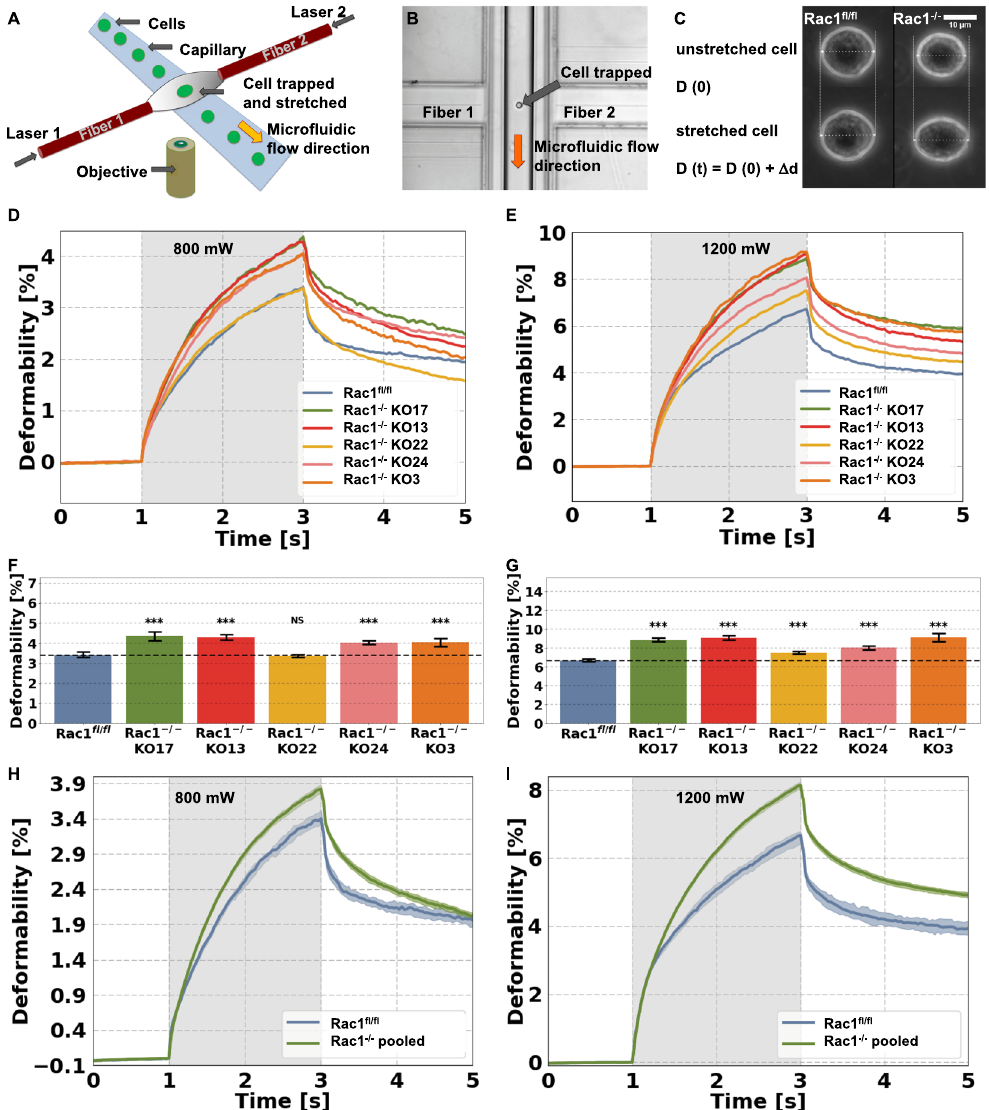
Figure 1. Mechanical properties such as the cellular deformability of five Rac1-deficient (Rac1 − / − ) clones and Rac1 fl/fl control cells were measured by using the Optical Cell Stretcher device. ( A ) Schematic image of the optical stretcher setup. ( B ) Image of the optofluidic microchip chamber with a cell that is trapped by the optical force. ( C ) Phase contrast image of an original Rac1 fl/fl cell (left images) and an original Rac1 − / − cell (right images) trapped (100 mW laser powers) at the onset of the stretching by two opposite laser beams (upper images) and maximally stretched after two seconds of high-power irradiation (1200 mW, lower images). ( D , E ) Deformability curves during the first second each cell is trapped, followed by stretching for 2 s with low laser powers of 800 mW ( D ) and high laser powers of 1200 mW ( E ). After the stretching process, the viscoelastic relaxation is observed for 2 s. For low and high stretch forces, Rac1 − / − clones KO3, KO13, KO17, KO22, and KO24 were pronouncedly more deformable at their long axis (parallel to the beam axes) compared to Rac1 fl/fl cells. ( F , G ) Data are presented as median values. Upper bar graphs in F and G are data sets from optical stretcher measurements of all five Rac1 − / − cell clones and Rac1 fl/fl cells expressed by the creep deformation median values of J (t = 3 s) with SD at 800 mW laser power or 1200 mW laser power, respectively. The deformability of Rac1 − / − pooled (all clones are measured together) and Rac1 fl/fl cells are shown at a stretch power of 800 mW ( H ) and 1200 mW ( I ). ( F – I ) Data are presented as median values with a 95.45% confidence interval. *** p < 0.001and NS = not